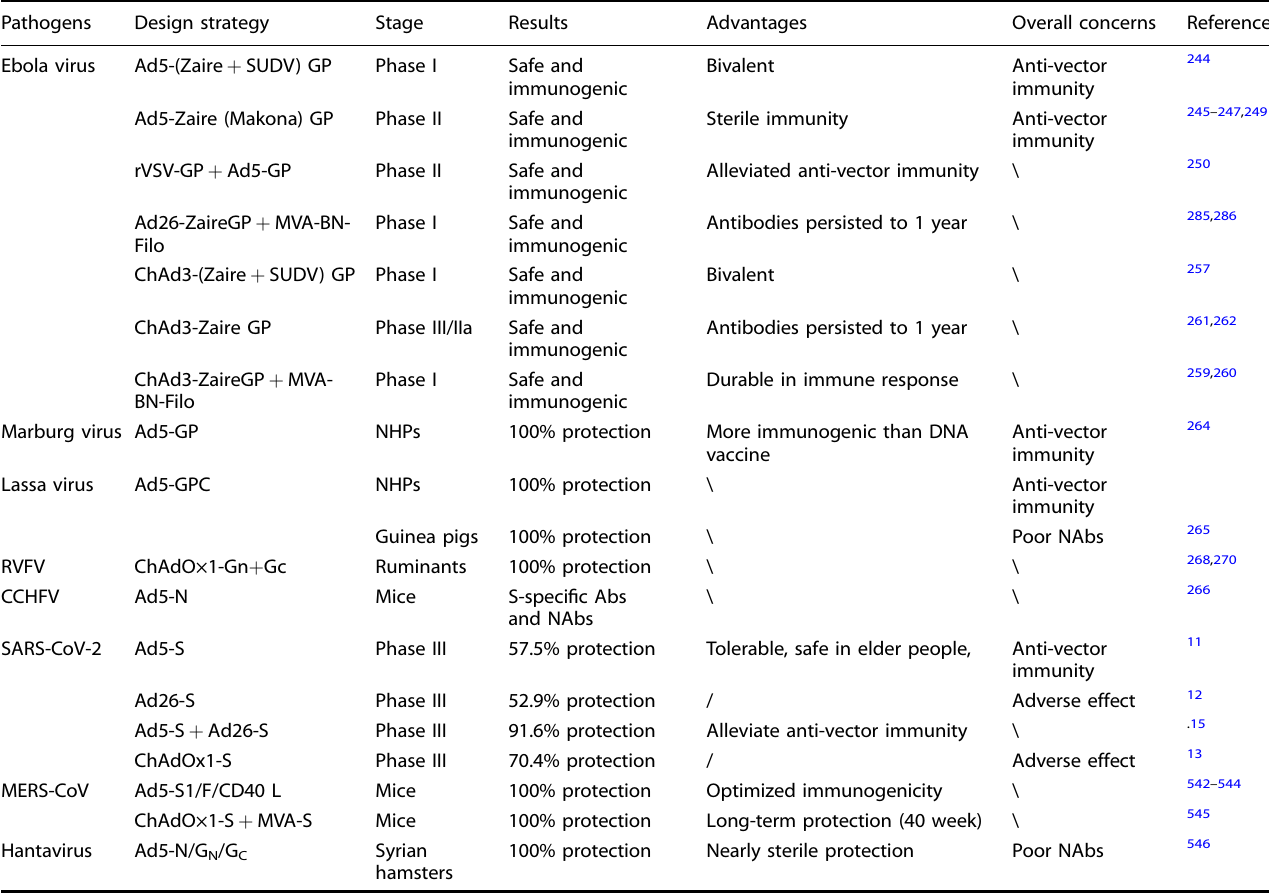
Table 8. Vaccine candidates based on adenovirus vectors Pathogens Design